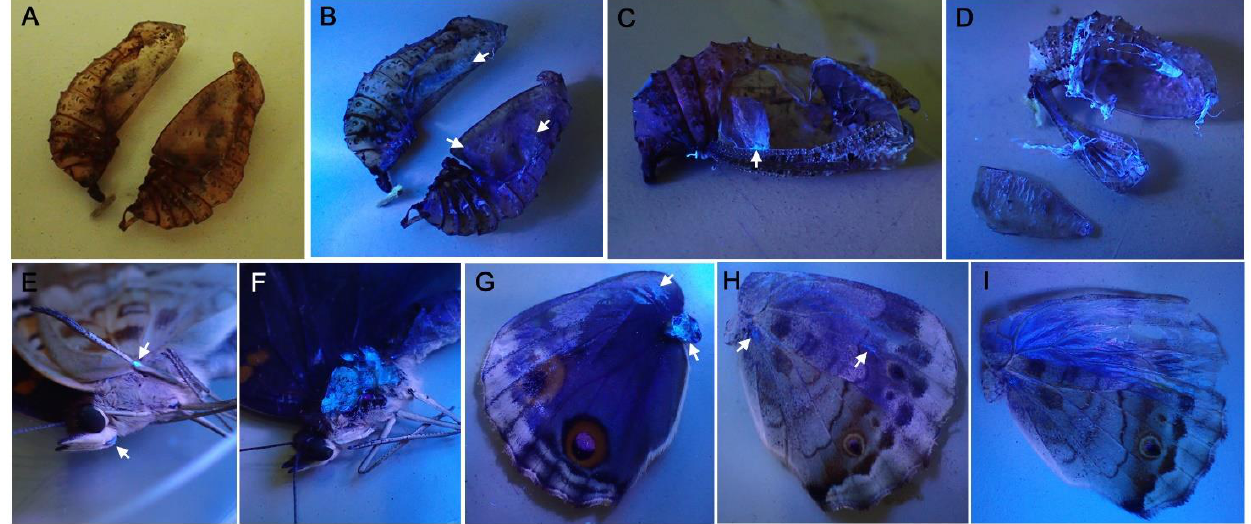
Figure 7. FB28 fluorescent signals from the post-pupation pupal and adult cuticle structures. ( A ) A pupal case of sagittal cut under white light. ( B ) The same specimen of A under ultraviolet light. Blue fluorescent signals are detected from many parts, but arrows indicate representative ones. ( C ). A pupal case with the forewing-lift operation. An arrow indicates the FB28 fluorescent signal from the thin cuticle covering the dorsal surface of the hindwing. ( D ) A dissected pupal case. The inner side of the cuticle covering the dorsal forewing is shown at the bottom left side of this panel, showing blue fluorescence. ( E ) Leg joint showing blue fluorescence. ( F ) Thorax muscle after removal of the exoskeleton, showing strong blue fluorescence. ( G ) Dorsal side of an adult hindwing. Cover scales at the anterior part were removed. Arrows indicate wing joint and wing base showing blue signals. ( H ) Ventral side of an adult hindwing. Arrows indicate fluorescent signals from the wing basal membrane due to scale removal. ( I ) Ventral side of an adult hindwing. Fluorescent signals were detected from the wing basal membrane. Cover and ground scales at the anterior part were removed.